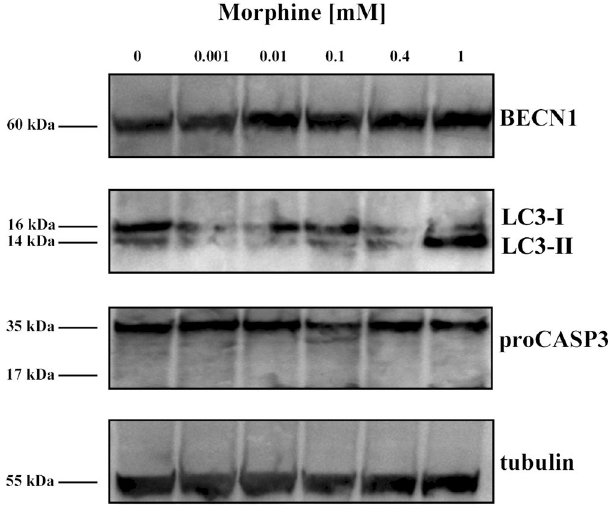
Figure 5. Cropped images representative of western blot analysis showing the expression of autophagic related markers BECN1, LC3 (LC3-I and LC3-II) and the apoptotic related marker proCASP3/CASP3, in hMSCs exposed to different concentration of morphine sulphate for eighteen days. Original blots representative of each tested marker are included in Supplementary Figure S1. To hybridize each marker separately, blots were cut based on the molecular weight of the proteins and empty lanes were removed by trimming the